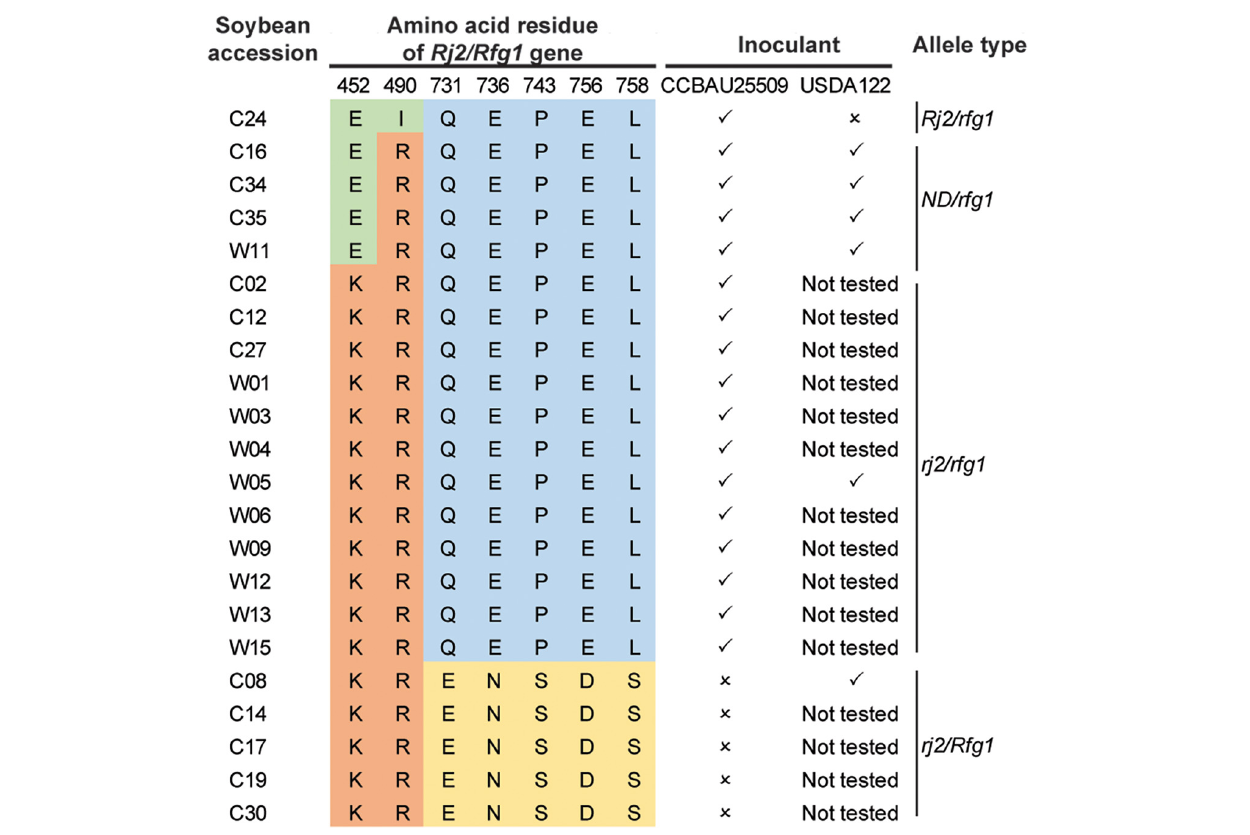
FIGURE 4 | Genotypes and nodulation phenotypes of 22 soybean accessions. (cid:88) : able to form nodules; × : unable to form nodules. ND, not previously detected.